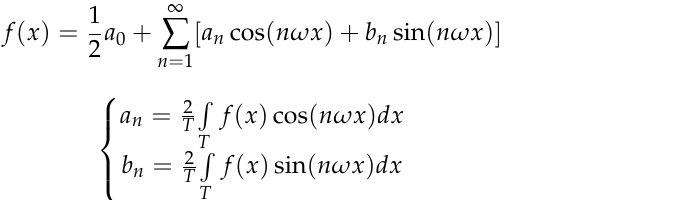
Figure 3. Operating waveforms with DPS modulation scheme. For a periodic signal f ( x ), it can be expanded into the form shown in (3), i.e., Fourier series.